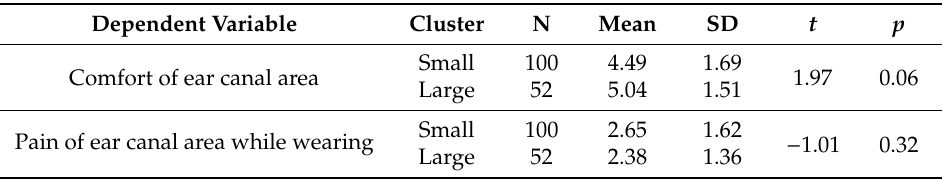
Table 10. Results of independent sample t -test for wearing comfort di ff erence according to ear canal length